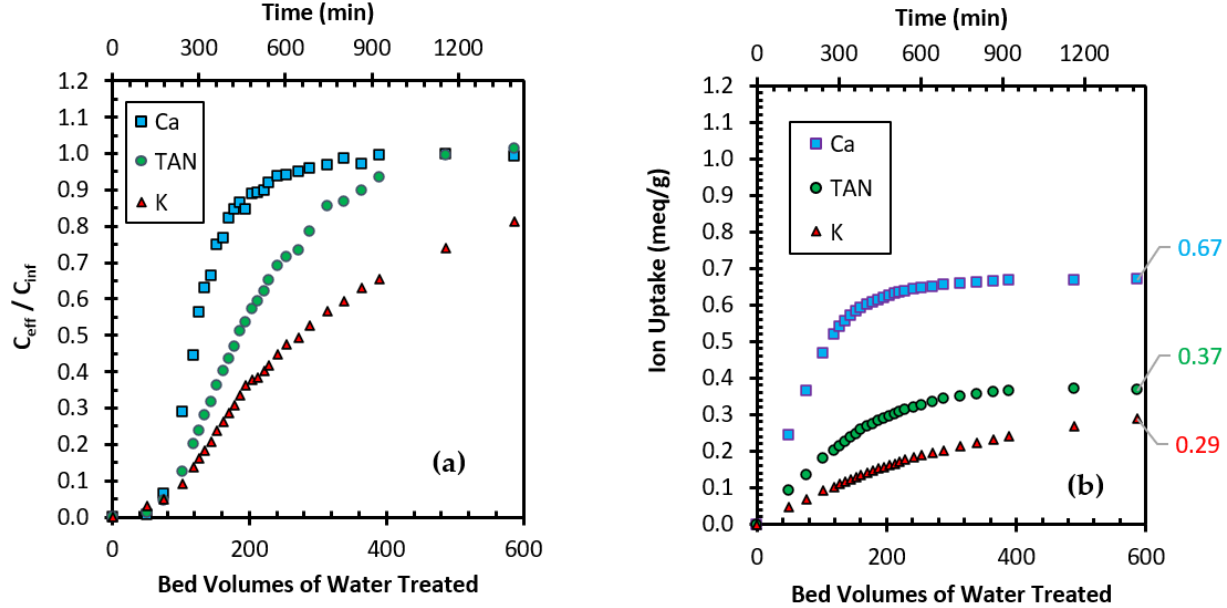
Figure 6. Column’s SL2 loading cycle: ( a ) Ion breakthrough; ( b ) Ion uptake versus bed volumes of water treated.